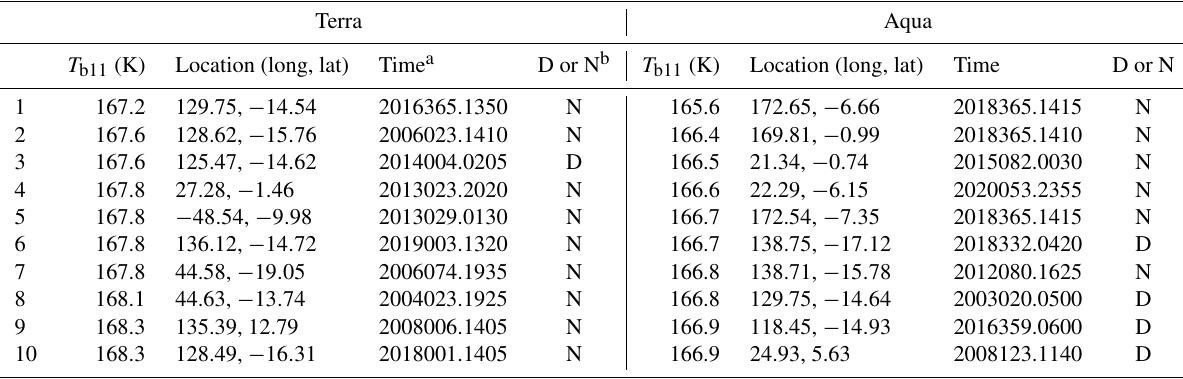
Table 2. Summary of the top 10 coldest OTs from Terra and Aqua, respectively. Terra